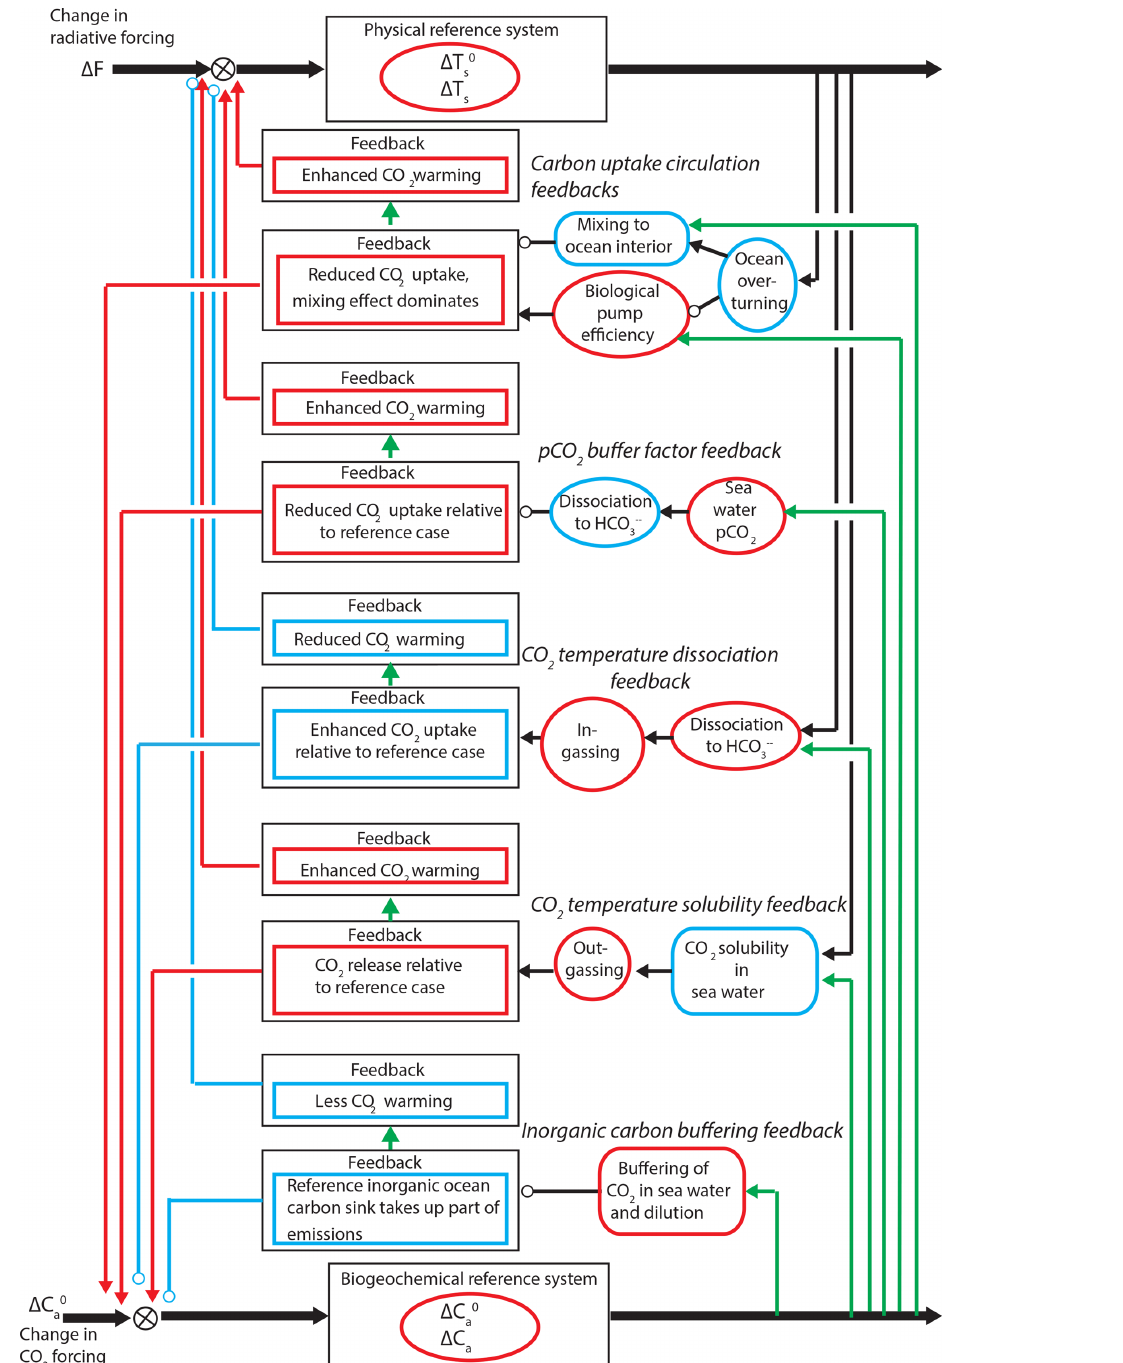
Figure 13. Schematic of important ocean biogeochemistry feedbacks. Arrows indicate positive coupling; open circles indicate negative coupling. Changes in state variables are indicated by ellipses, changes in processes by rounded rectangles. Red indicates increasing values of variables, strengthening of processes, or positive feedbacks; blue indicates the opposite. Green arrows and lines indicate couplings of biogeochemical processes to physical processes. The change in surface air temperature (cid:49)T s in the presence of feedback is different from the change (cid:49)T 0 s without feedback. The change in greenhouse gas concentration (cid:49)C a in the presence of a biogeochemical feedback is different from that without this feedback ( (cid:49)C 0 a